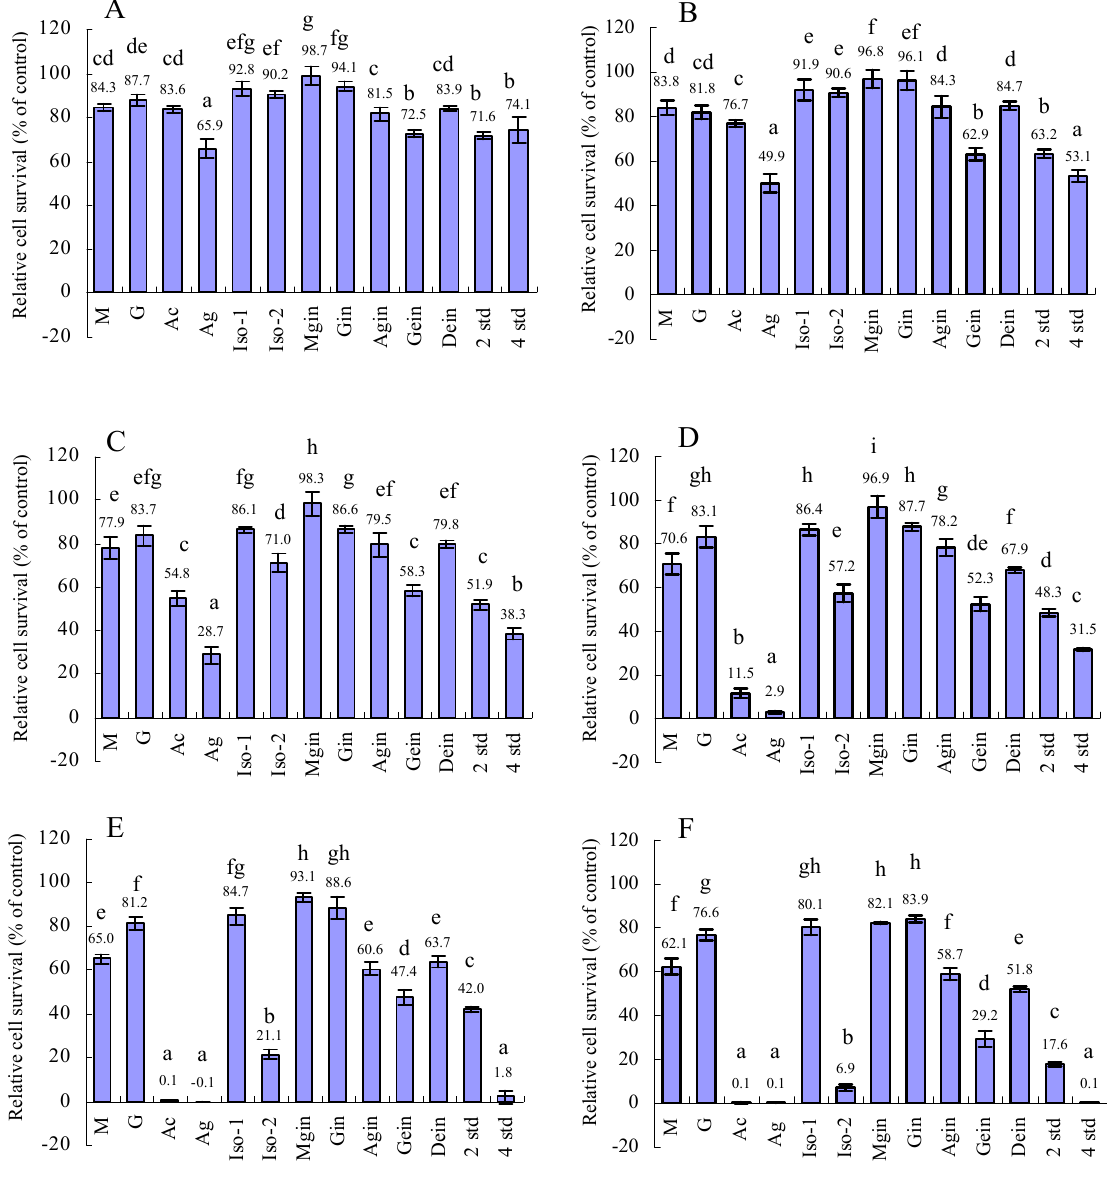
Figure 1. Inhibition effect of isoflavones on Hep G2 cell growth as determined by MTT. (A) 5 μ g/mL (B) 10 μ g/mL (C) 20 μ g/mL (D) 30 μ g/mL (E) 40 μ g/mL (F) 50 μ